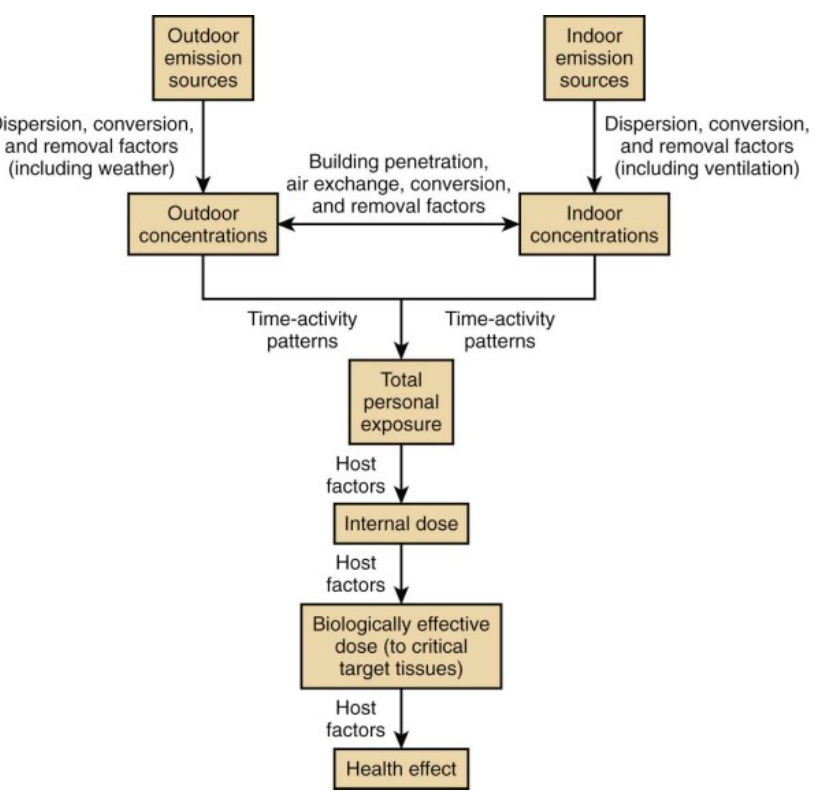
Figure 1. Relations between outdoor and indoor air pollution and health effects [30].